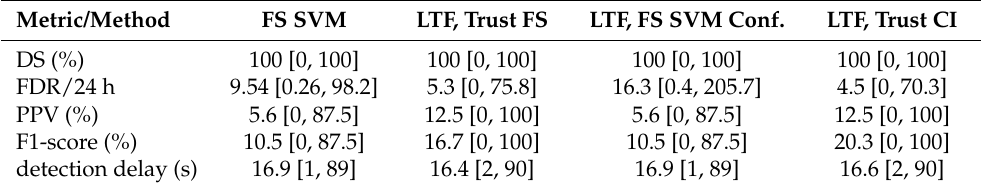
Table 4. Median [range] of performances of: FS SVM; LTF with the confidences of this SVM (FS SVM conf.); and LTF with trust models trained on CI (trust CI) and FS (trust FS)